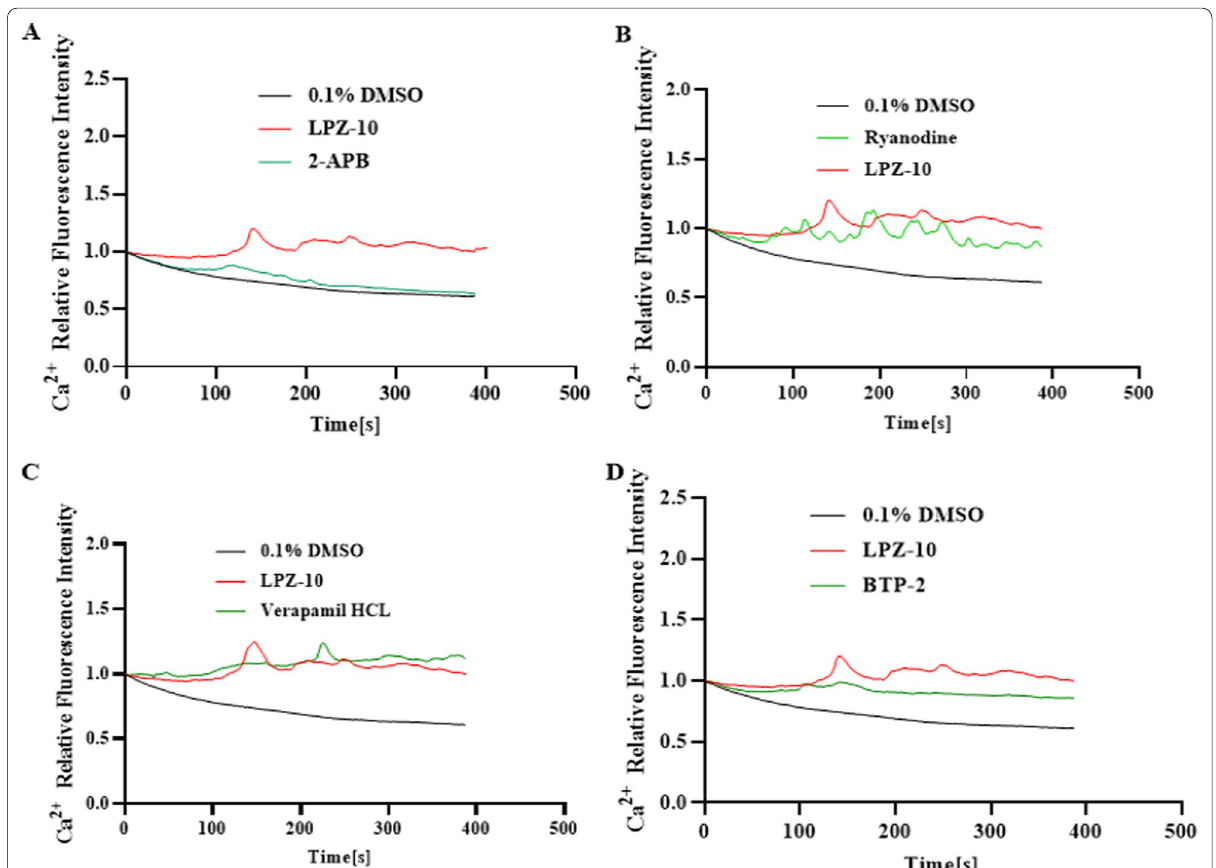
Fig. 5 Relative calcium fluorescence change curves. A Relative [Ca 2 + ] i response in MC3T3-E1 cells that were preincubated with 2-APB in Ca 2 + -free medium. B Relative [Ca 2 + ] i response in MC3T3-E1 cells that were preincubated with ryanodine in Ca 2 + -free medium. C Relative [Ca 2 + ] i response in MC3T3-E1 cells that were preincubated with verapamil in Ca 2 + -containing medium. D Relative [Ca 2 + ] i response in MC3T3-E1 cells that were preincubated with BTP-2 in Ca 2 + -containing medium (n =